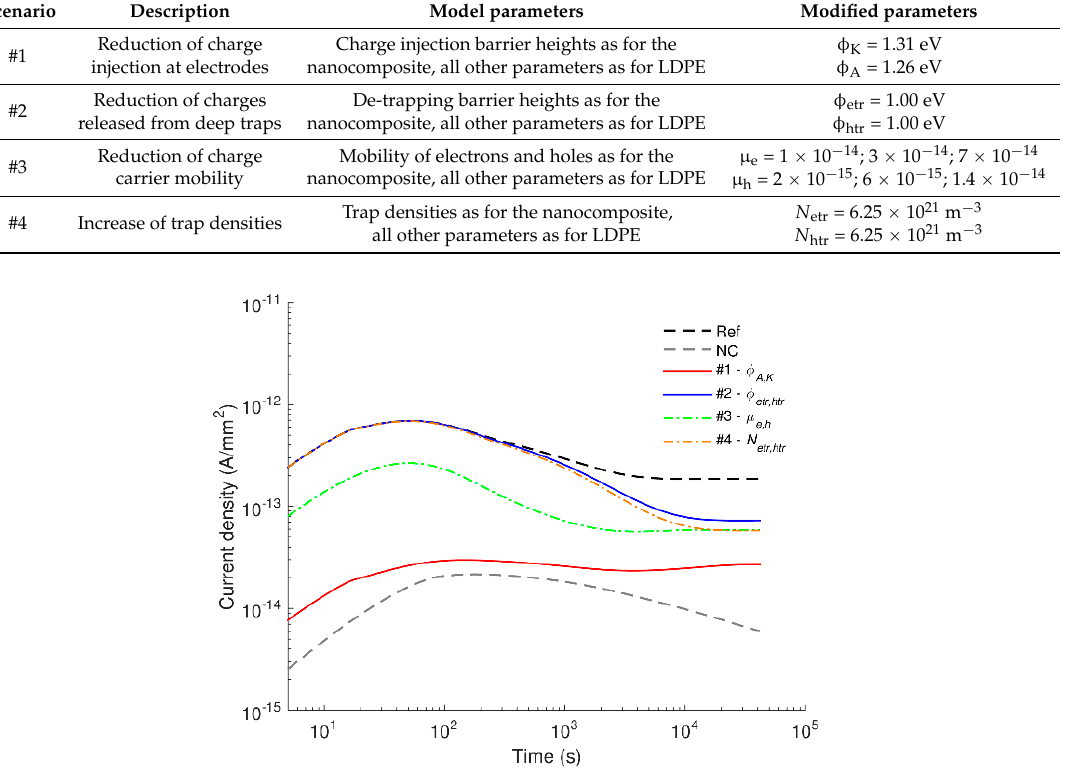
Figure 8. Simulated conduction currents at 40 °C obtained by varying model parameters. Four scenarios are considered as shown in Table 2. The parameters being changed are indicated in the legend.